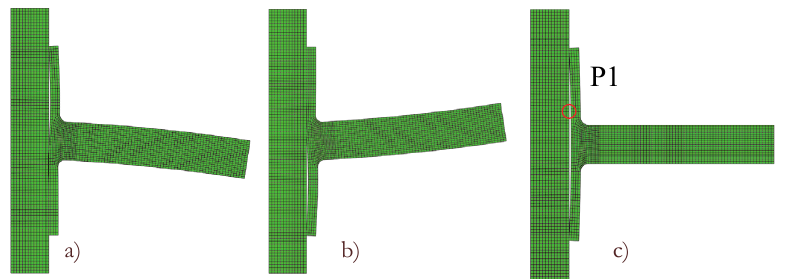
Figure 9: Deformed mesh plots at step 1, step 2 and step 4,